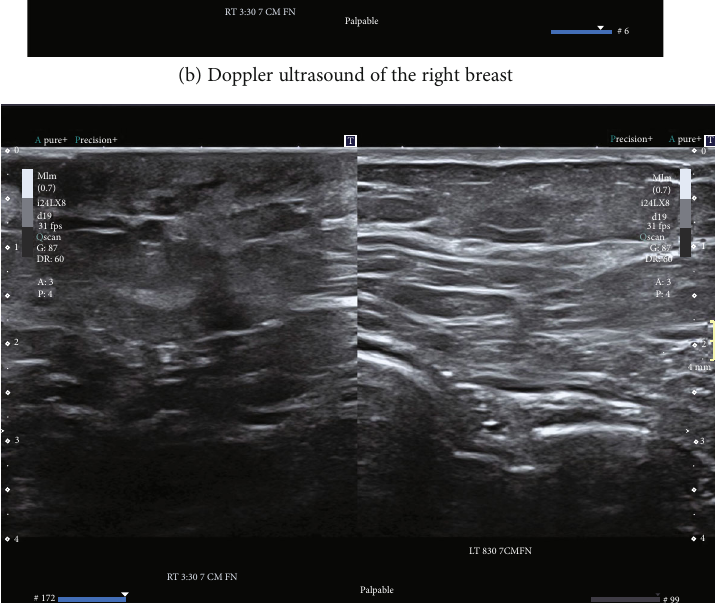
(c) Grayscale ultrasound comparing the two breasts, demonstrating the area of concern within the right breast, and the corresponding contralateral side with normal breast tissue and skin Figure 4: (a – c) Selected ultrasound exam on the right breast shows marked skin thickening measuring up to 7.2mm, in the area of concern (a), associated with increased fl ow